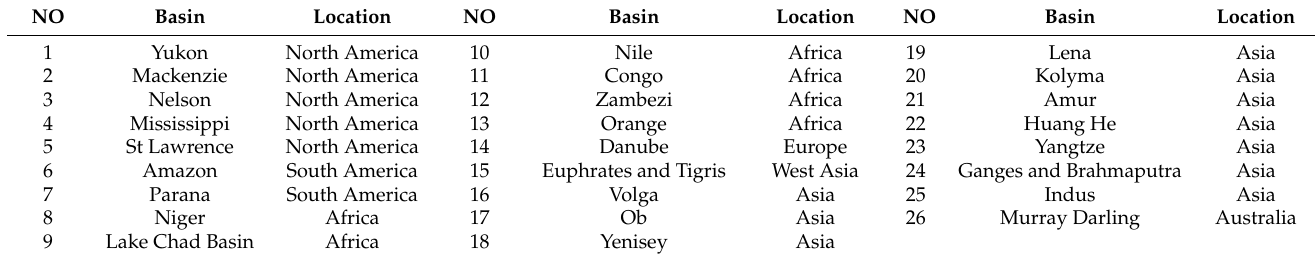
Figure 1. Location map of 26 regions worldwide (The boundary file is from http://hydroweb.theia- land.fr/?lang=en&basin, accessed on 5 July 2021). Table 1. The information of the 26